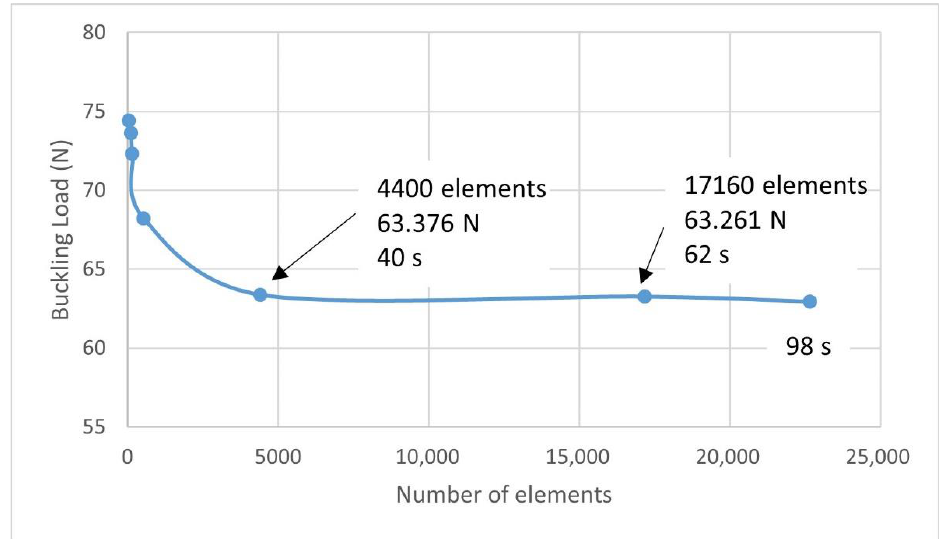
Figure 8. Simulation in Abaqus of the buckling test. Mesh sensibility analysis.